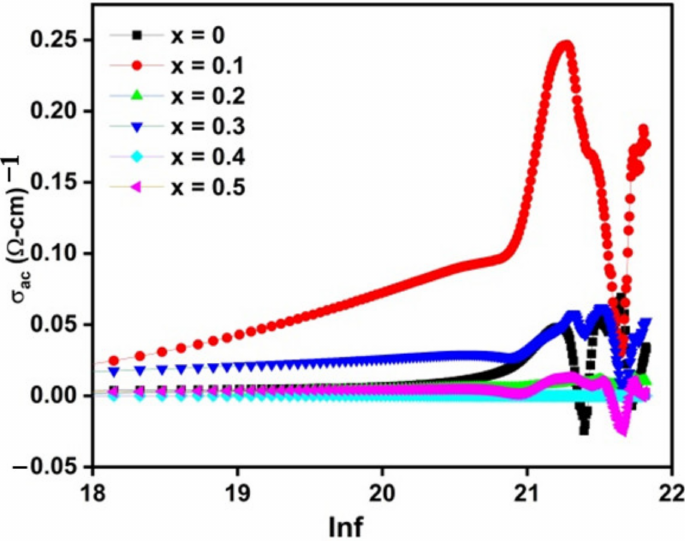
Figure 6. Variation in AC conductivity with frequency for pure cobalt ferrite ( x = 0) and doped CoFe 2 − 2x Li x Zn x O 4 ( x = 0.1–0.5) at room